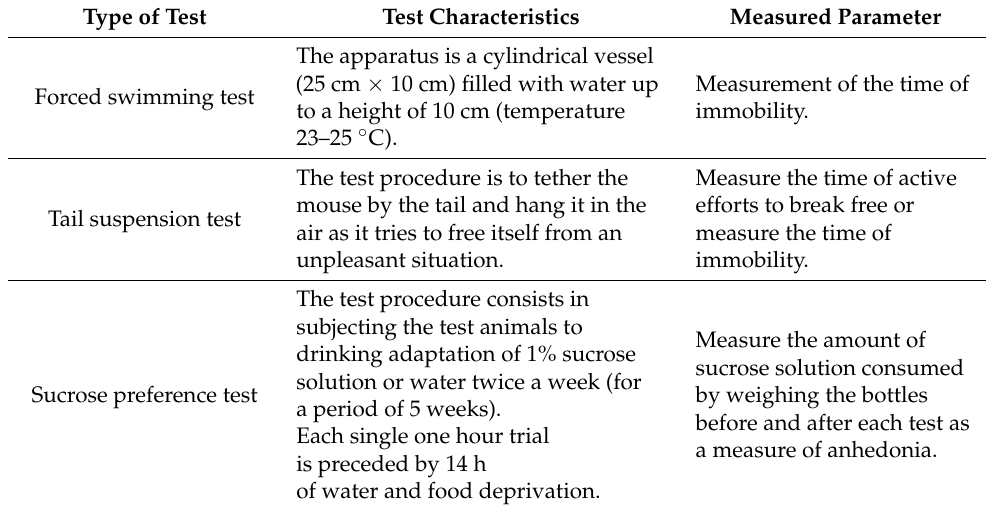
Table 1. Review of behavioral tests to assess depression-like behavior.